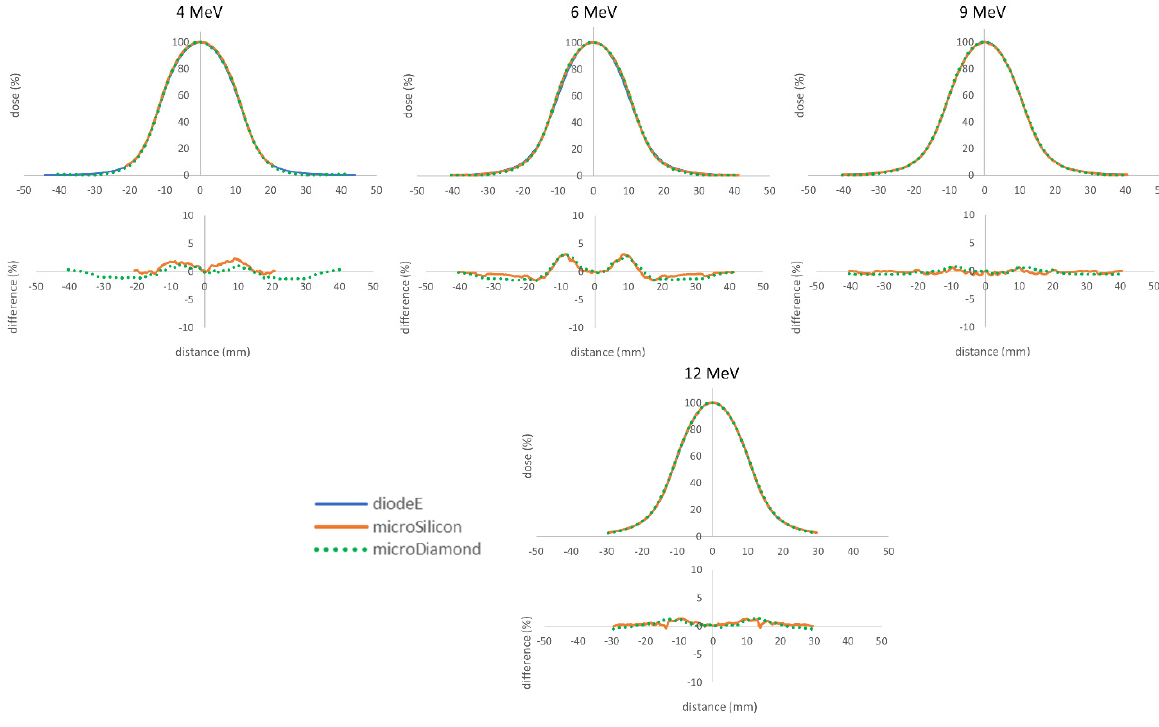
Figure 3. Crossline beam profiles, measured by the different solid-state detectors, and % respective difference over the entire off-axis range between microDiamond and microSilicon measurements and diode E data. Table 4. Field size and 80-20% penumbra values for all circular applicators, measured by the solid-